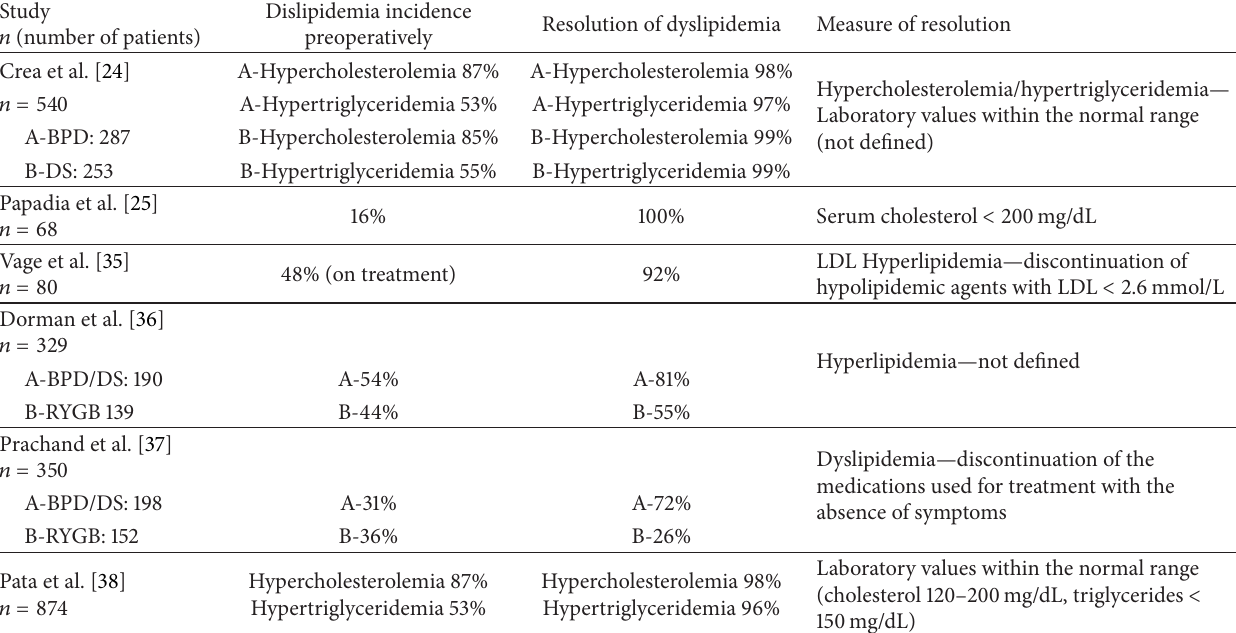
Table 3: Effect of biliopancreatic diversion with duodenal switch on dyslipidemia.